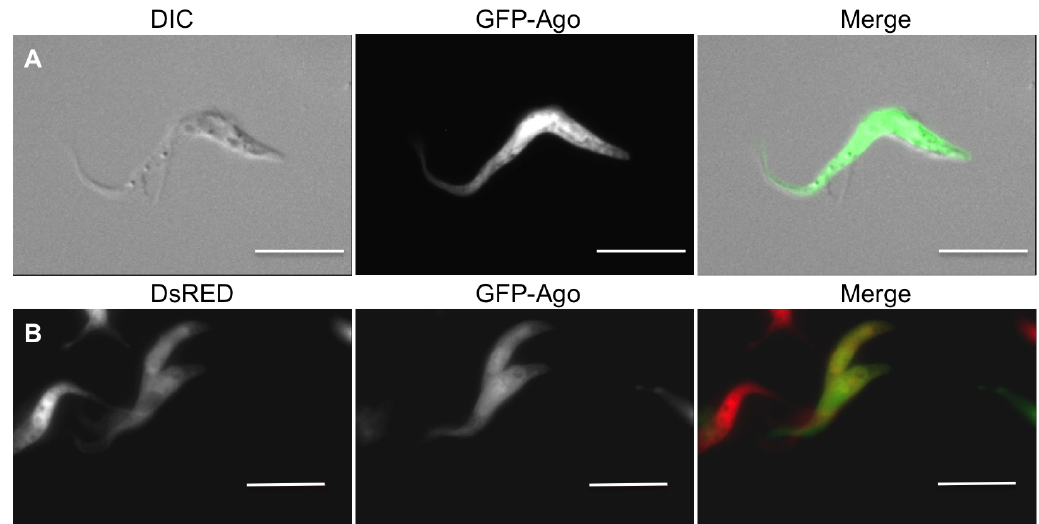
Figure 5. GFP-tagged Ago1 partially localises to the flagellum and can be exchanged between cells. A : Fluorescence microscopy of wild-type cells expressing GFP-Ago. B : Fluorescence microscopy of co-cultured wild-type cells expressing DsRED or GFP-Ago. Scale bars indicate